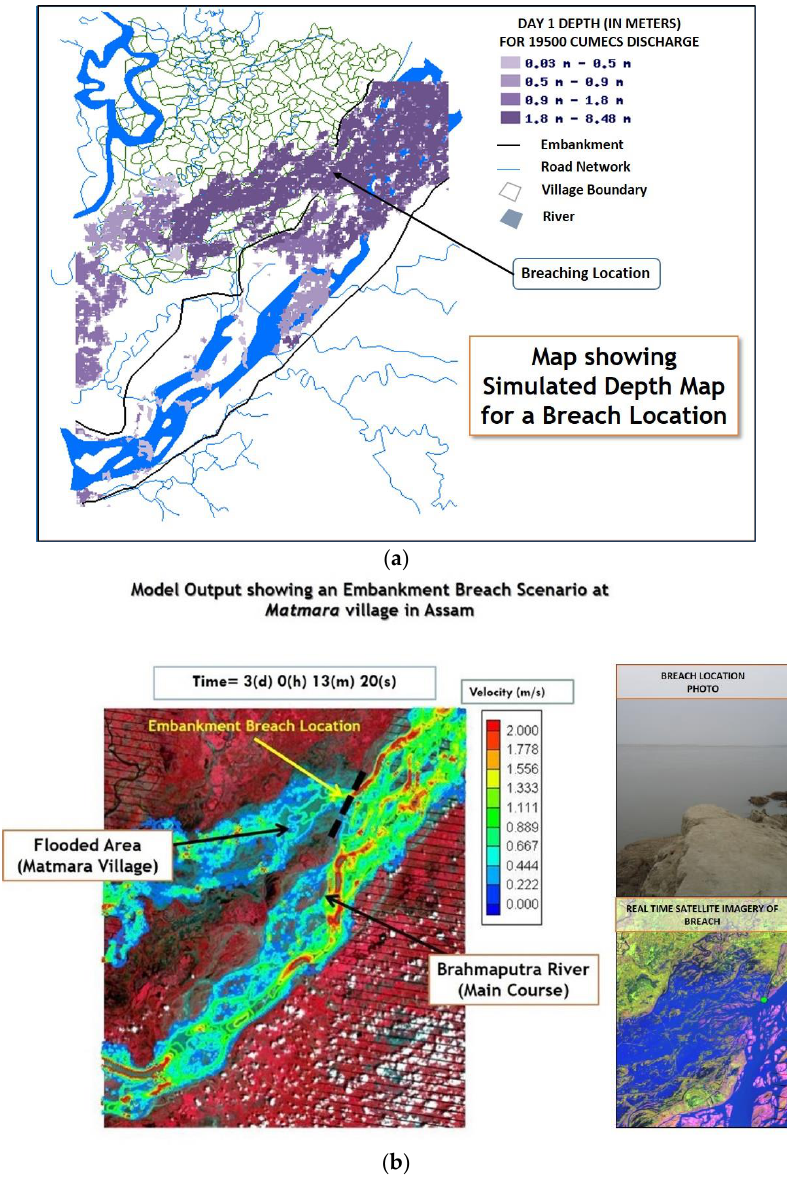
Figure 10. ( a ) Map showing simulated depth map for a breach location (Day 1 depth (in meters) for 19,500-cumec discharge. ( b ) Map showing simulated velocity map for a breach location (Day 3 (in m/s) for 19,500-cumec discharge.